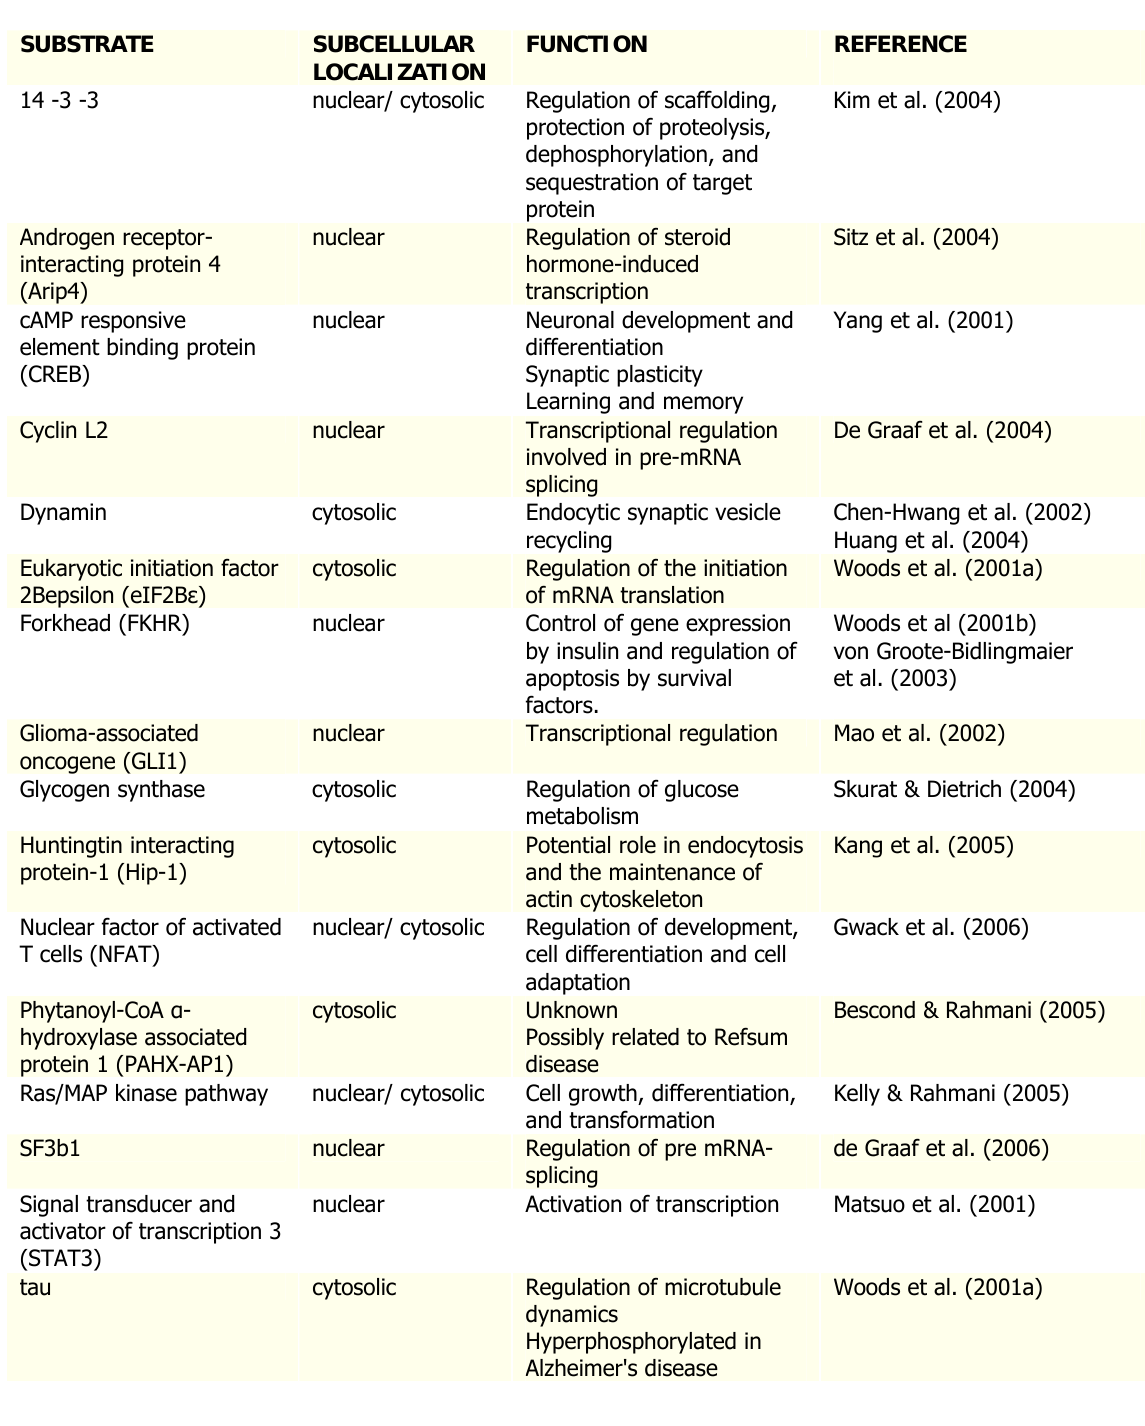
Nuclear and Cytoplasmic Interactors and Substrates of DYRK1A, Subcellular Localization, and Physiological